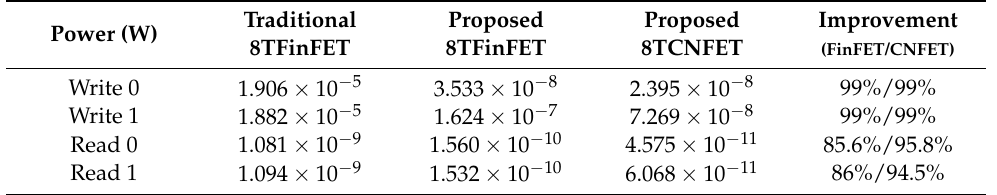
Table 9. Dynamic power consumption